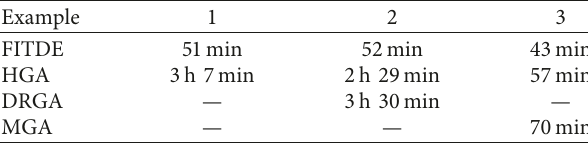
Table 8: Comparisons of running time (h: hour; min: